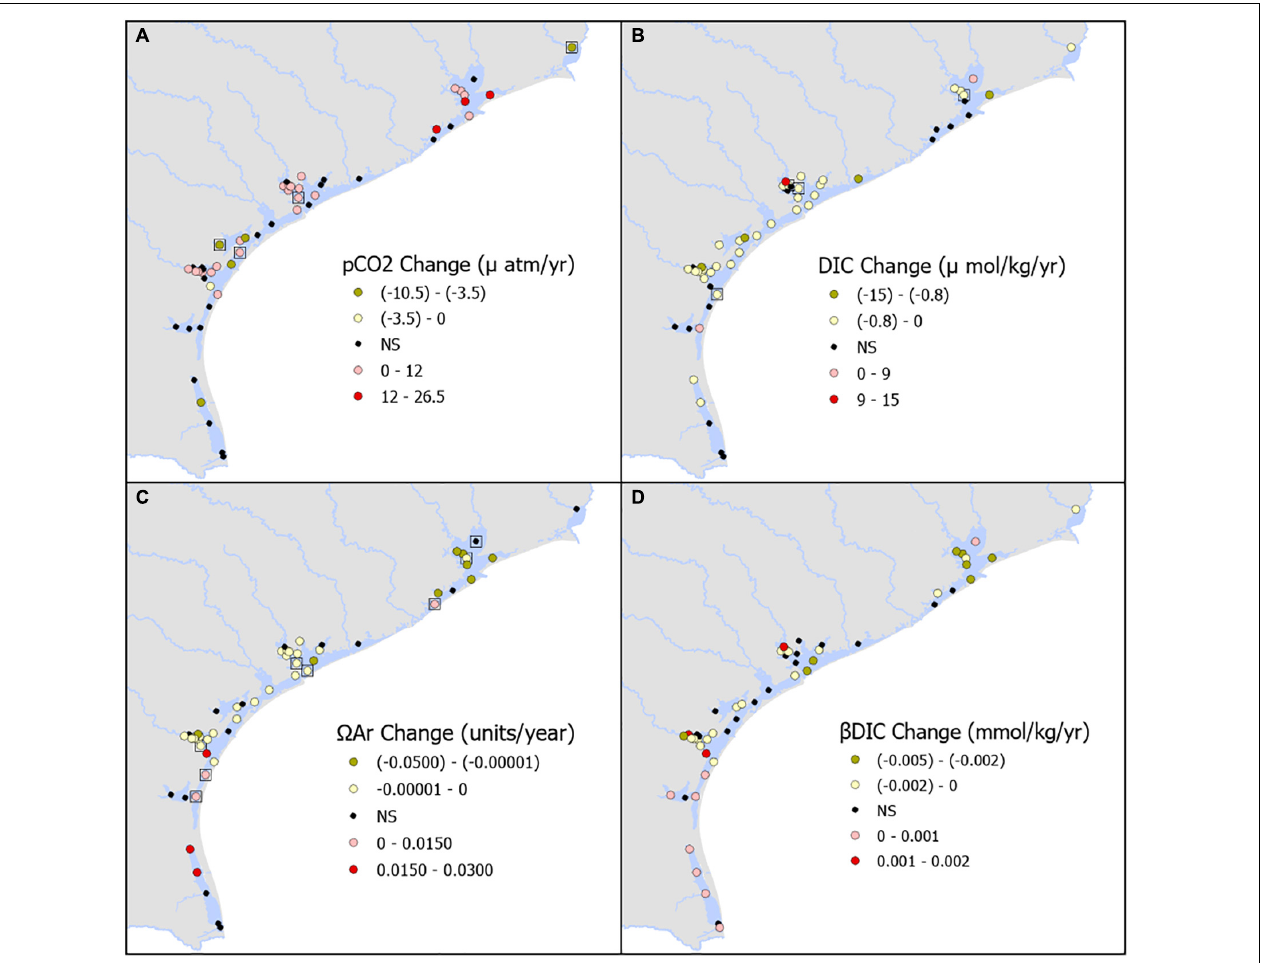
FIGURE 3 | Annual rate of change in calculated carbonate system parameters— p CO 2 (A) , dissolved inorganic carbon (B) , (cid:127) Ar (C) , and β DIC (D) . Black squares surrounding individual stations in (A–C) indicate locations where long-term trends detected by TS regression were not validated (significant trend of the same sign) by the simulation